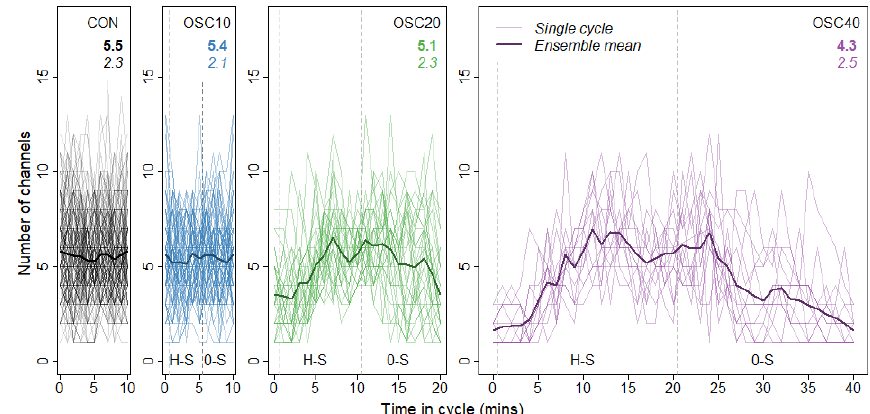
Figure 6. The number of connected channels versus time in the sediment supply oscillation cycle. The number of channels was measured along a transect 1m down-fan. The thin lines represent each individual supply oscillation cycle; the thick line is the ensemble mean. H- S denotes the high-supply period; 0-S denotes zero sediment supply. Coloured text indicates each experiment’s time-averaged mean (in bold) and standard deviation (in italics).